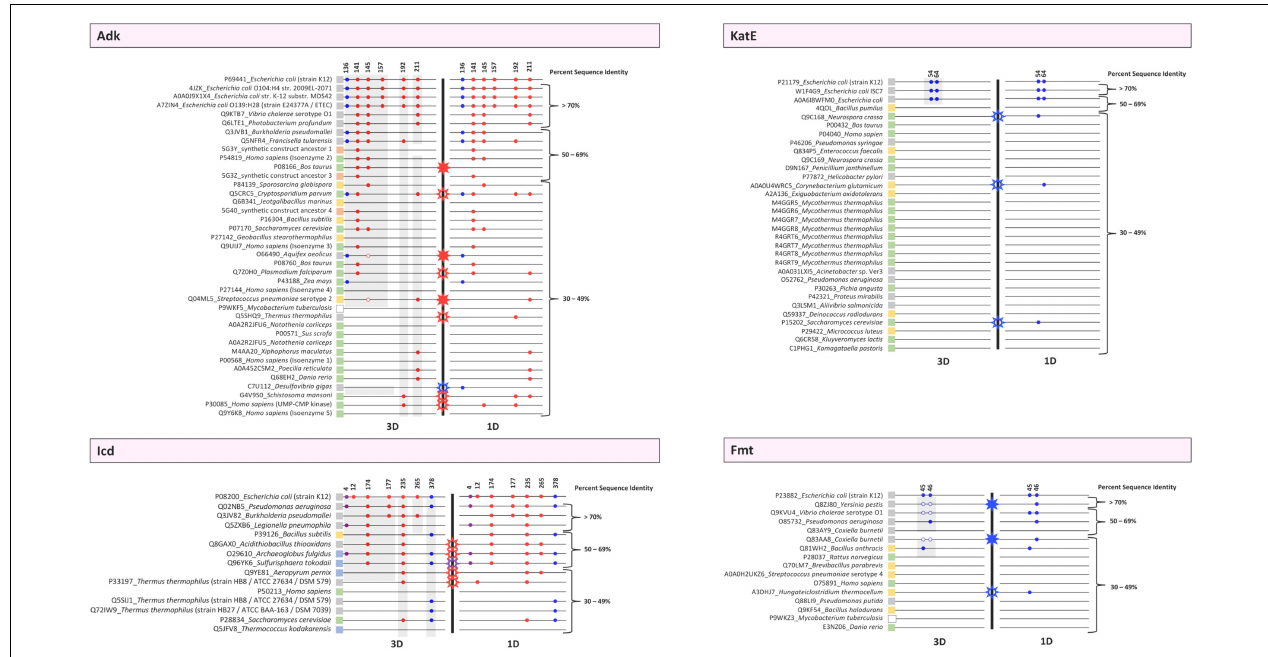
FIGURE 6 | Conservation plots of selected lysine residues in both 3D structures and primary sequences of the target E. coli K-12 proteins (Adk, Icd, KatE, Fmt) and their homologs. Sequence and structural alignments between the target proteins and their homologs were analyzed to determine whether selected lysine residues were conserved in 1D and 3D. Alignments were performed using Cobalt and FATCAT and were then manually inspected. Each protein is indicated by its UniProt ID followed by the name of the organism. Strain or isozyme information is also included. PDB IDs were used when no UniProt ID existed for a given protein. Colored boxes adjacent to these labels correspond to whether they are Eukaryotes (green), Archaea (blue), Bacteria [Gram-negative (gray), Gram-positive (yellow), or Gram-variable (white)], or synthetic constructs (orange). Each protein is represented by a thin black line and organized based on percent sequence identity compared to the E. coli K-12 target protein. A thick black line separates the 3D and 1D conservation plots. Colored circles are used to indicate whether a lysine residue is conserved in both the target and homolog. The colors of the circles correspond to lysine acetyltransferase (KAT) acetylation sites (blue), AcP acetylation sites (red), or both KAT and AcP acetylation sites (purple). These sites were identified in previous studies with E. coli K-12 and are indicated by their residue number. The circles only indicate the presence of a lysine residue in 1D and 3D in homologs and not whether the residue has been identified as acetylated in the homolog in vivo . For Adk, open circles indicate a lysine residue was present during manual inspection of 3D structures but was not present in the FATCAT output. For Fmt, open circles mean that the residues were disordered in the structure but were present in the linear sequence for that region. Stars indicate a discrepancy between 3D and 1D lysine conservation within the same protein. Open stars represent a discrepancy in the 1D analysis, whereas filled stars represent a discrepancy in the 3D analysis. For example, if a residue is present in the 1D analysis but not the 3D analysis, an open star is shown. On the other hand, if a residue is present in the 3D analysis but not 1D analysis, a closed star is shown. The color of the stars corresponds to the type of acetylation site, i.e., KAT (blue), AcP (red), or both KAT and AcP (purple) that has the discrepancy. Gray highlighting on the 3D panels identifies proteins that contain similar structural domains as in the E. coli target proteins.